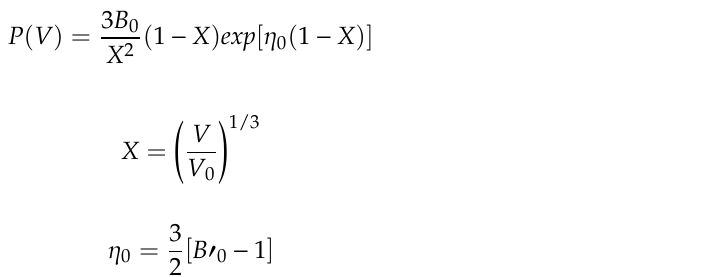
Figure 5. Evolution with pressure of the Sm-doped ceria cell volume for all the samples; experimental data are fitted by the third order Vinet EoS (continuous lines). Cell volumes of samples Sm20 and Sm30 are multiplied by 8 in order to make them comparable with those of Sm40, Sm50 and Sm60. Vertical error bars are hidden by data markers.